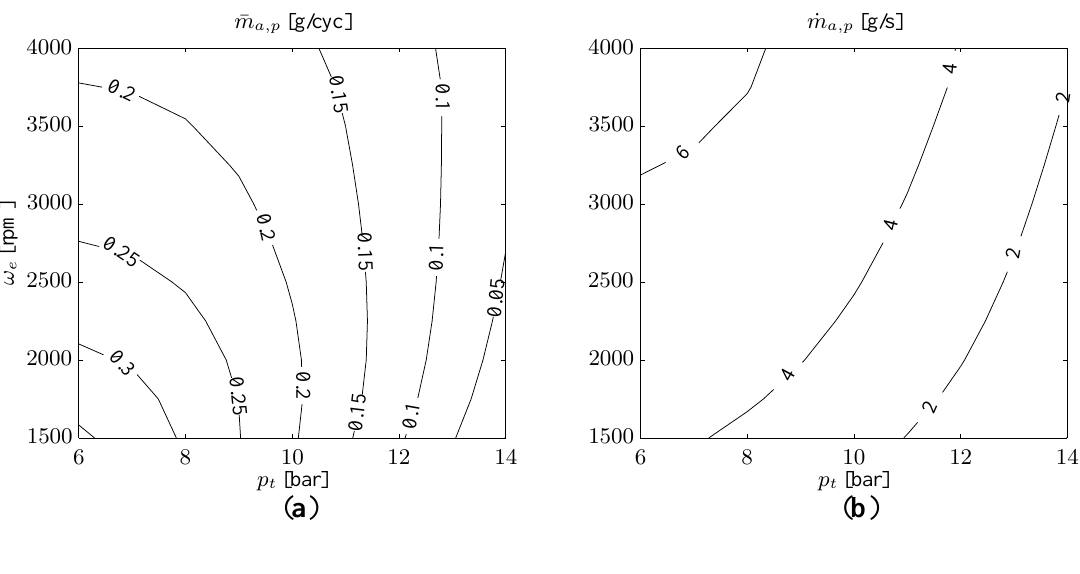
Figure 5. Pump mode performance for a later CV opening than in Figure 4. ( a ) Air mass transferred per cycle from cylinder to tank; and ( b ) mean air mass flow from cylinder to